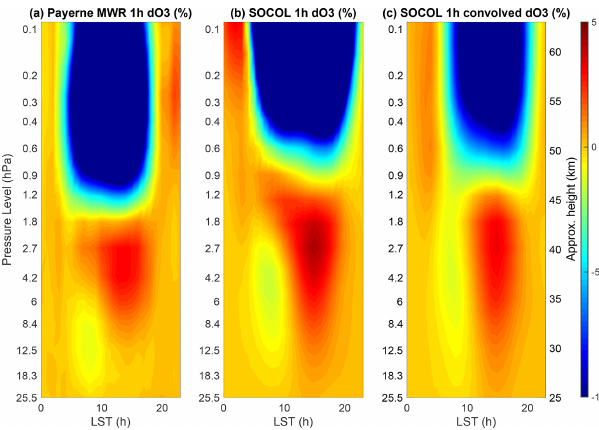
Figure 6. Annual mean O 3 daily cycle measured by (a) Payerne MWR and (b–c) simulated by SOCOL v3.0 with a time step of 1h.